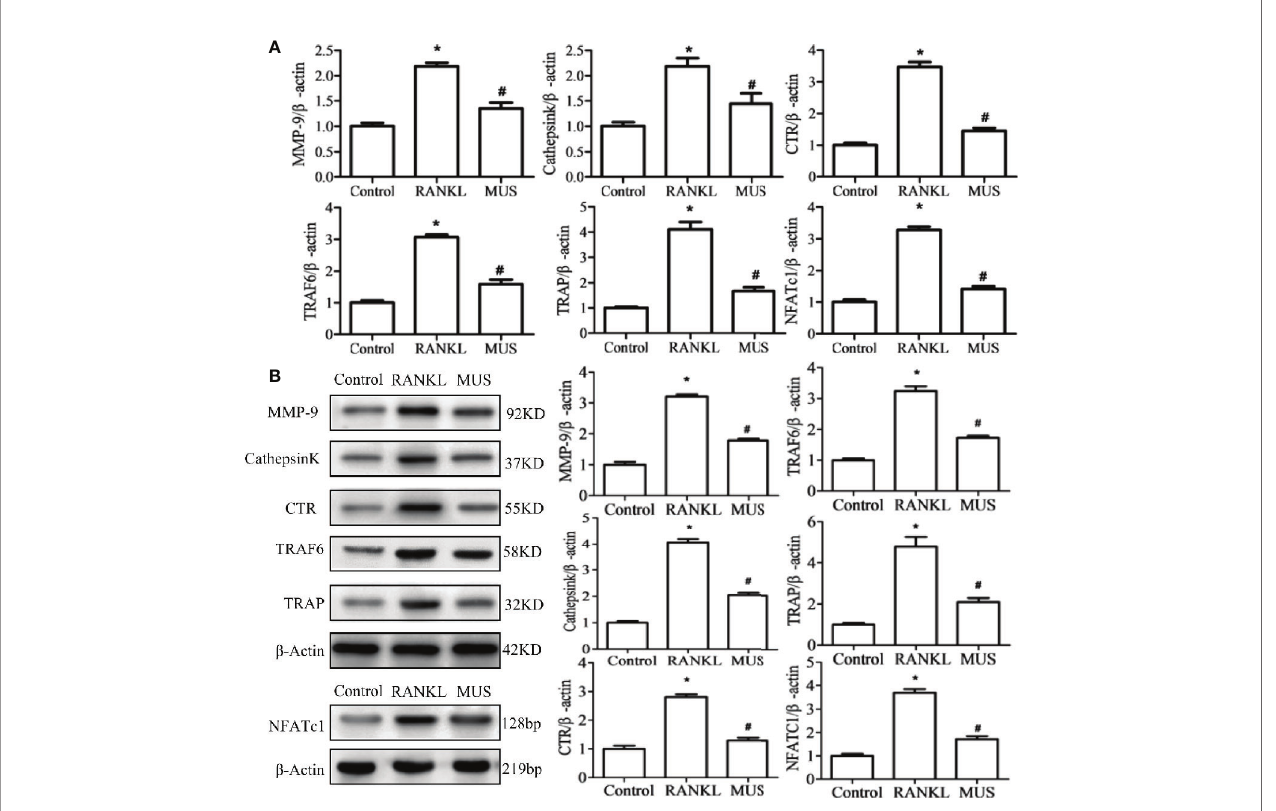
FIGURE 6 | Muscone suppresses the RANKL-induced RANK associated down-stream gene expression. By RT-PCR (A) and western blot (B) , muscone fi rstly suppresses the TRAF6 and the over-expressed NFATc1. And then, muscone withdraws expression levels of MMP-9, Cathepsin K, TRAP, and CTR in RAW264.7 cells. *P < 0.05 vs. the control group, #P < 0.05 vs. the RANKL-induced